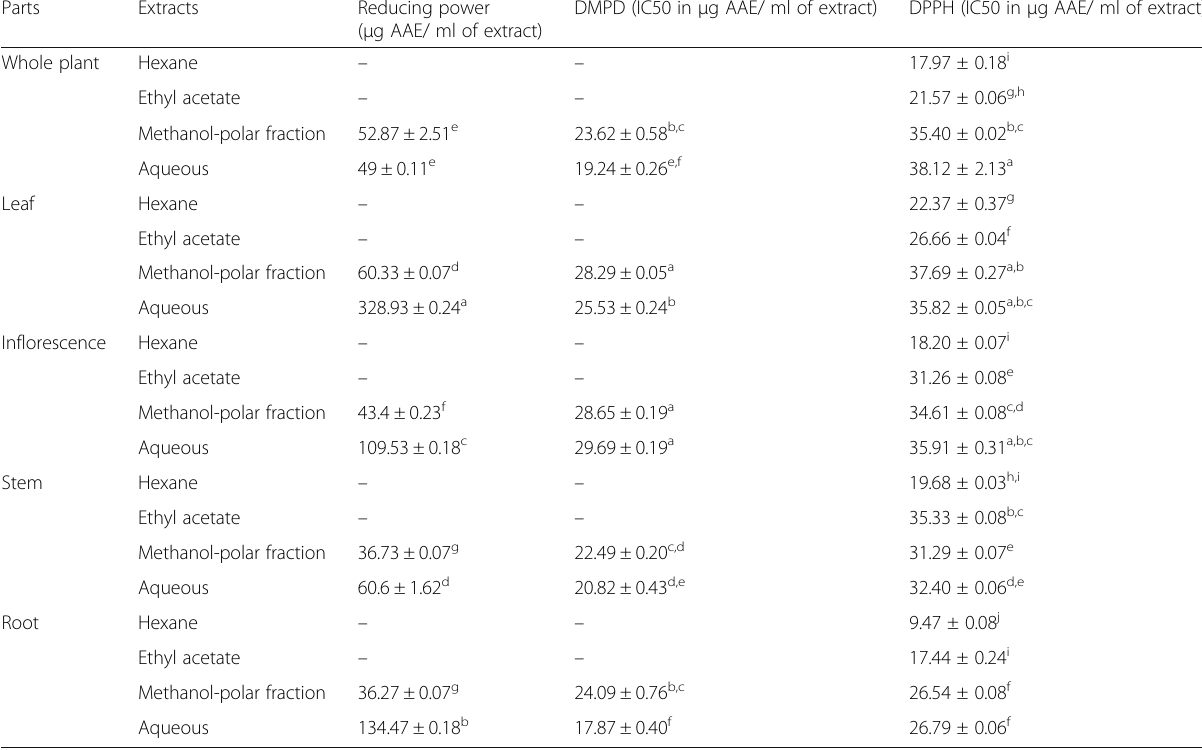
Table 4 Antioxidant activity of different parts of their extracts of S. indicus Parts